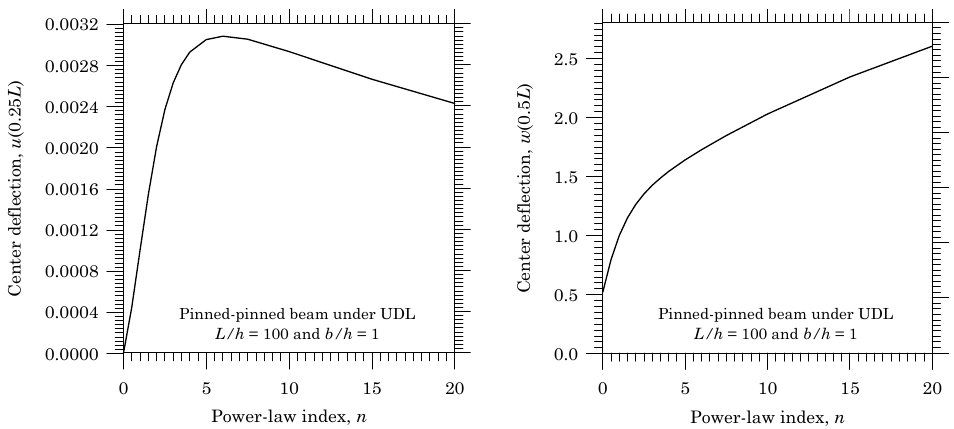
Figure 4. Plots of maximum displacements u ( 0.25 L ) and w ( 0.5 L ) versus n for pinned-pinned FGM beams under uniformly distributed transverse